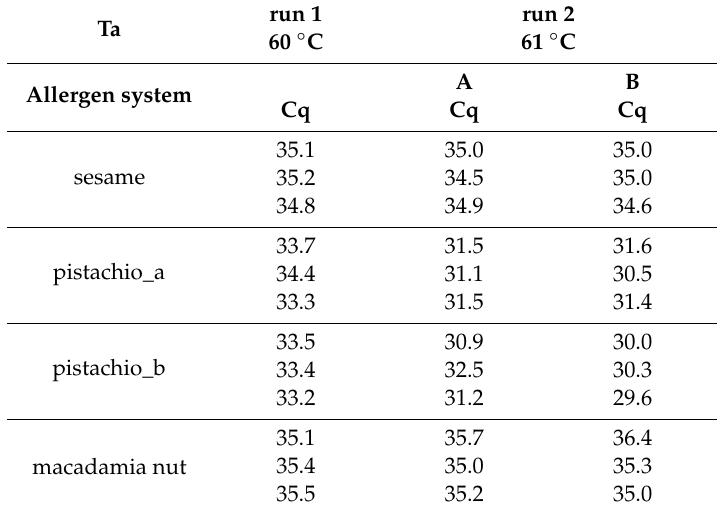
Table 5. Robustness results for sesame, pistachio (a–b), and macadamia nut